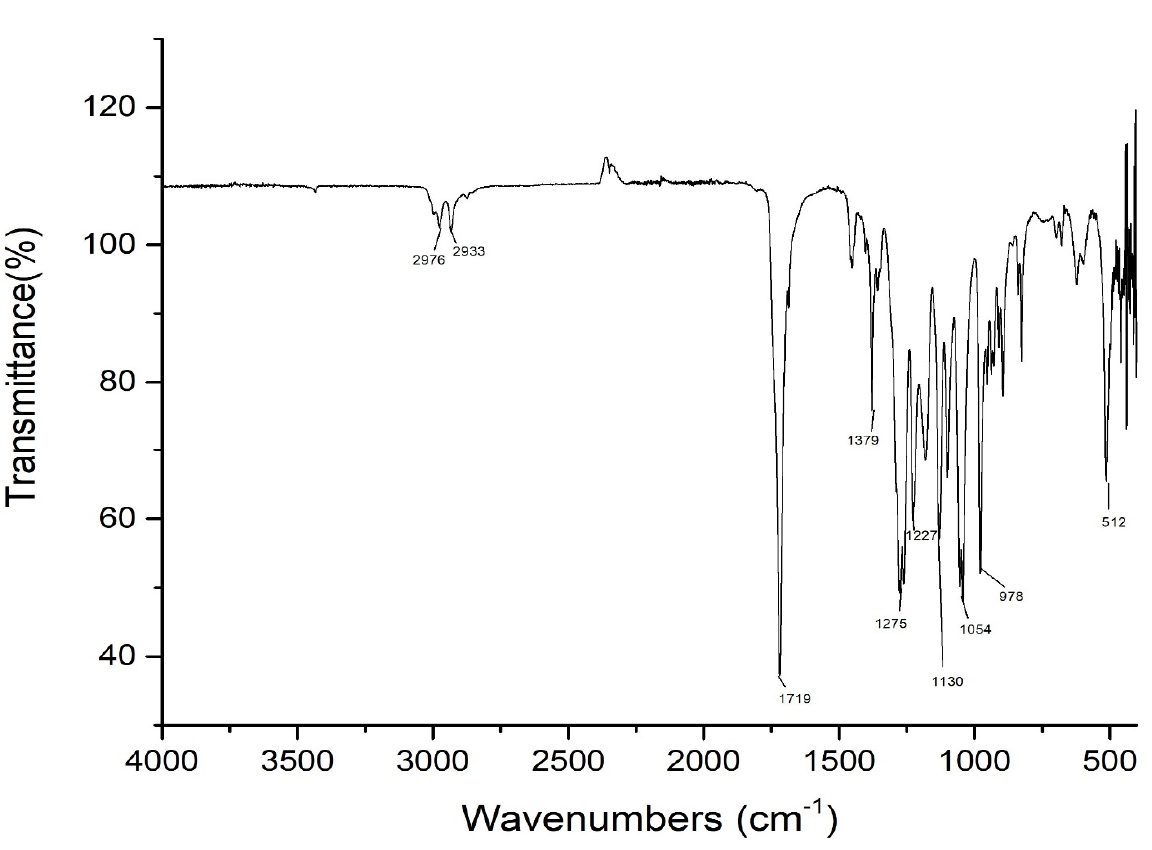
Figure 6. Characteristic of Fourier transform infrared (FTIR) spectra of P(3HB) obtained as a result of UV irradiation of Azotobacter chrocococcum AZ 3.